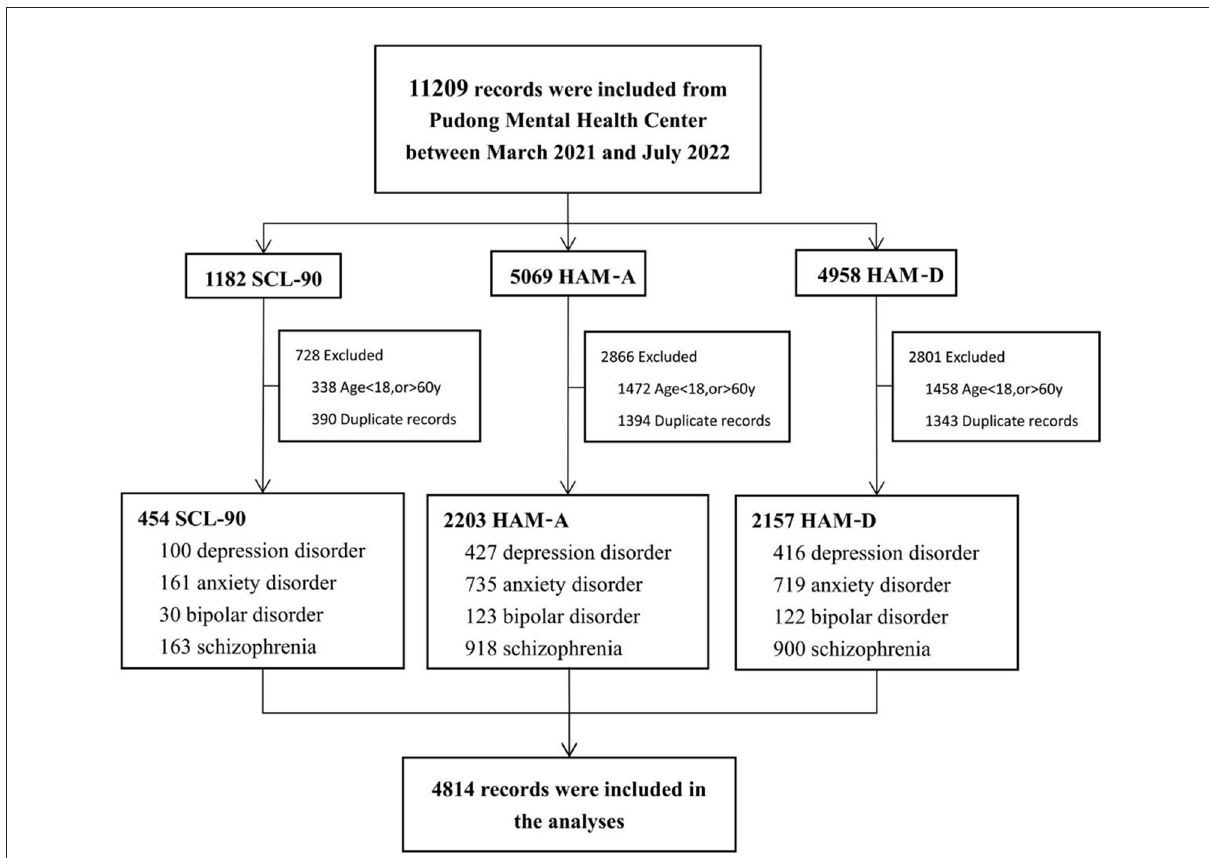
FIGURE1 Flow chart of experimental design. HAM-A, Hamilton Anxiety Rating Scale; HAM-D, Hamilton Depression Rating Scale; SCL-90, Symptom Checklist-90.